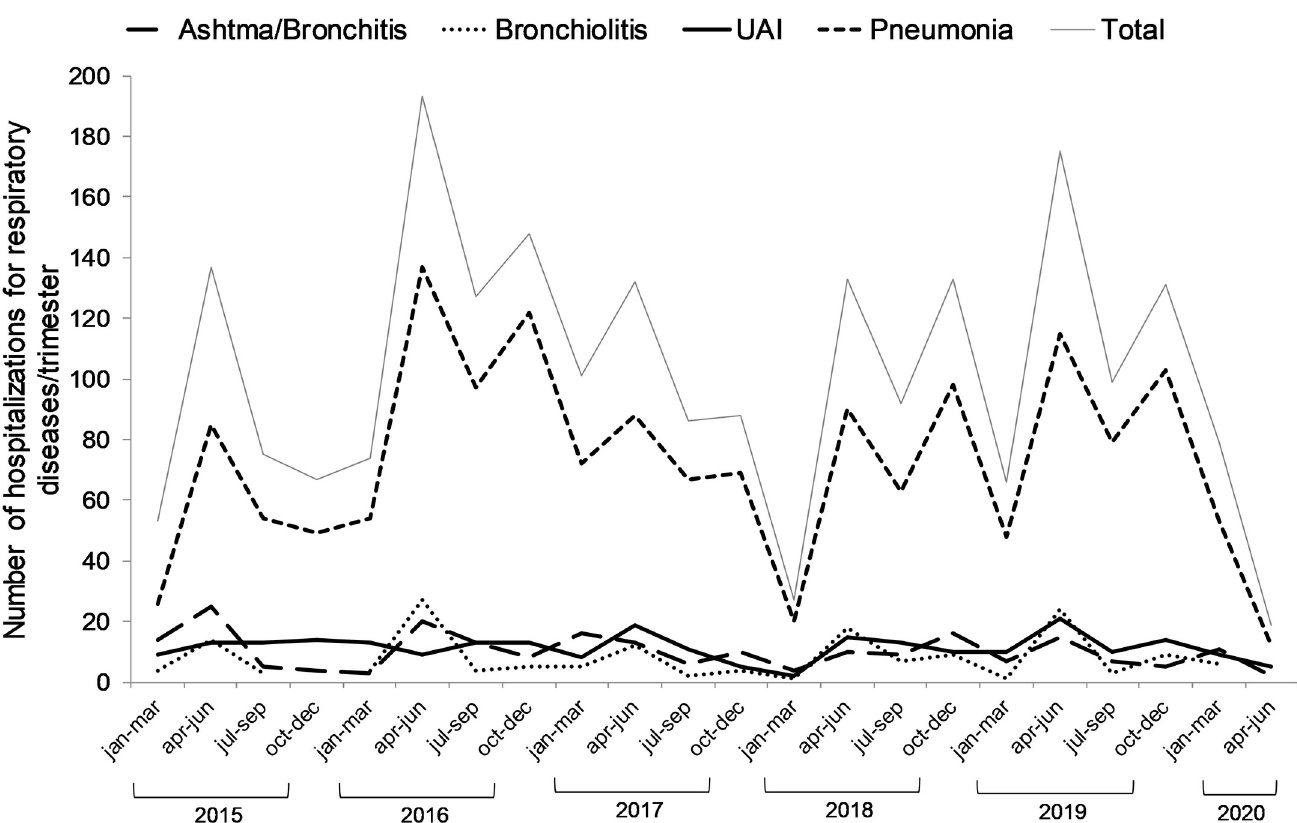
Fig 1. Distribution of the number of hospitalizations for respiratory diseases in pediatric patients from January 2015 to June 2020 total and according to diagnosis (n = 2236).